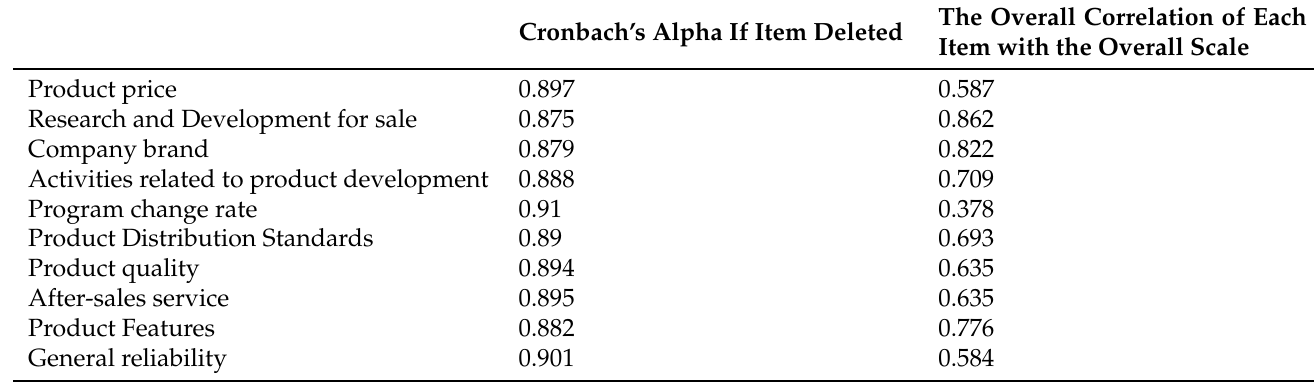
Table 8. Reliability test related to strategy.